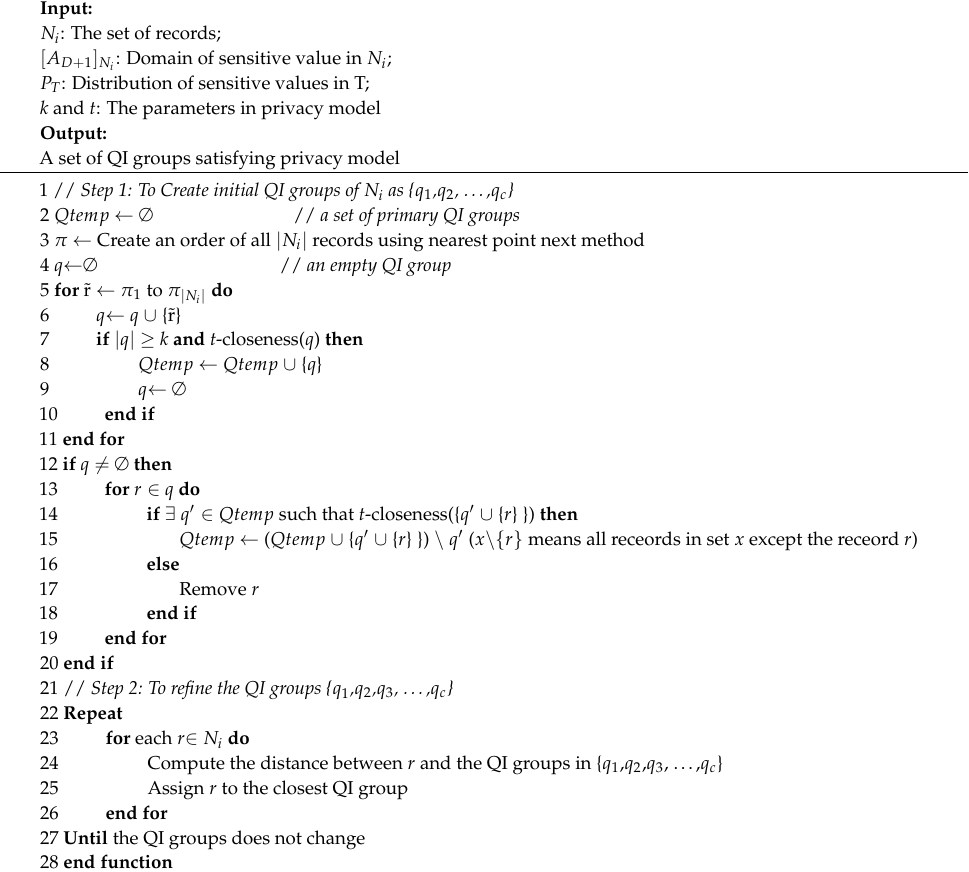
Algorithm 2: The t - k -Utility